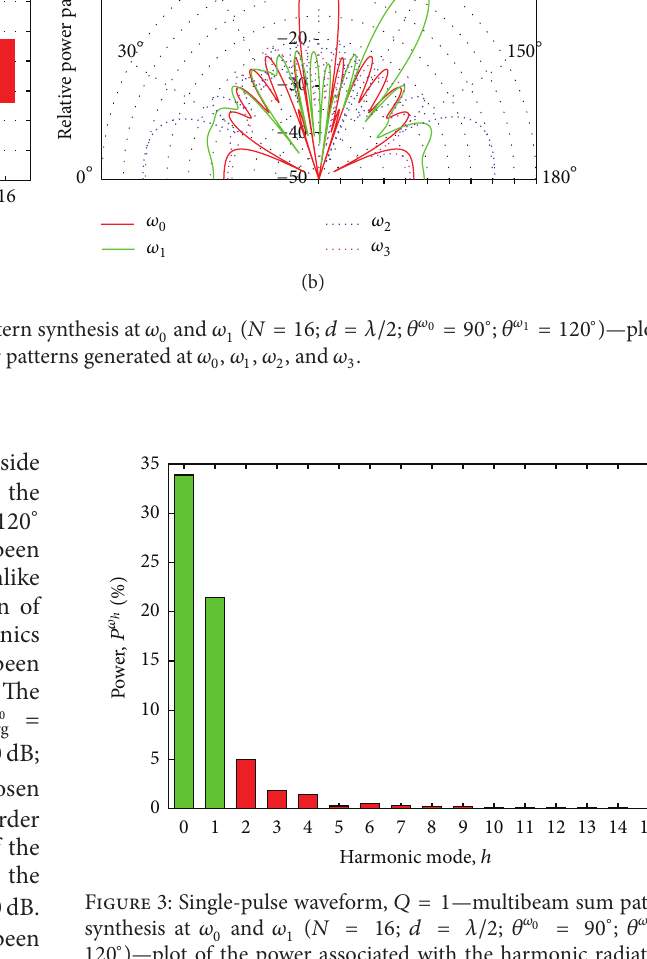
Figure 3: Single-pulse waveform, 𝑄 = 1 —multibeam sum pattern synthesis at 𝜔 0 and 𝜔 1 ( 𝑁 = 16 ; 𝑑 = 𝜆/2 ; 𝜃 𝜔 0 = 90 ∘ ; 𝜃 𝜔 1 = 120 ∘ )—plot of the power associated with the harmonic radiations in percentage on the total